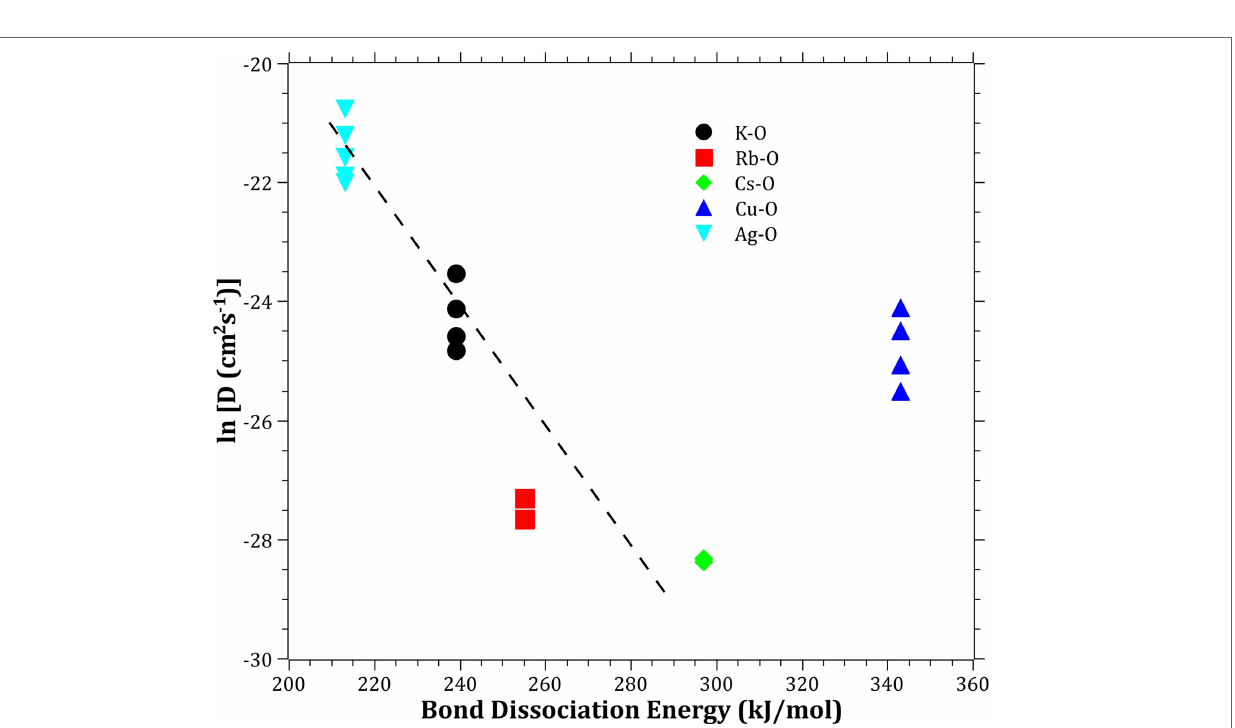
FiGUre 6 | Logarithm of the effective diffusion coefficient vs. enthalpy of formation . Data taken from Dean (1999).